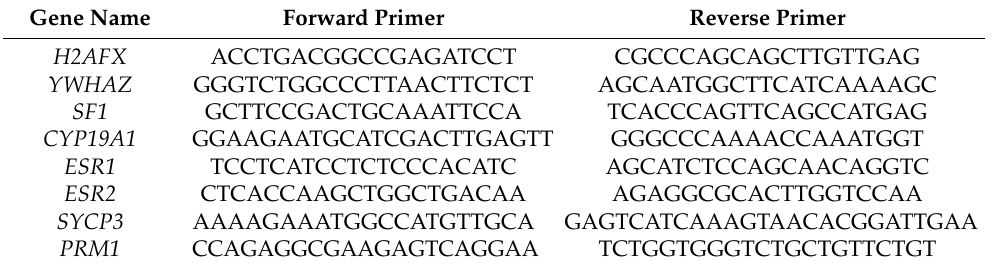
Table 1. Primers used by